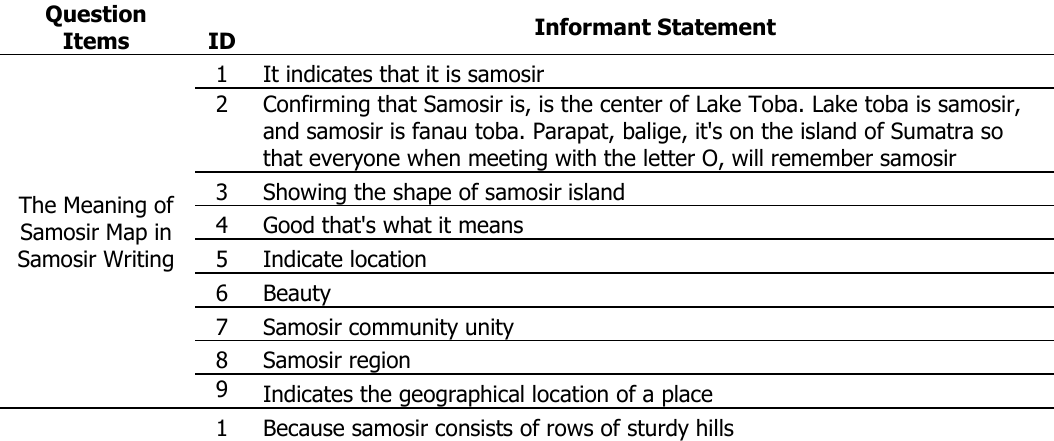
Table 5. Perception of Branding Based on